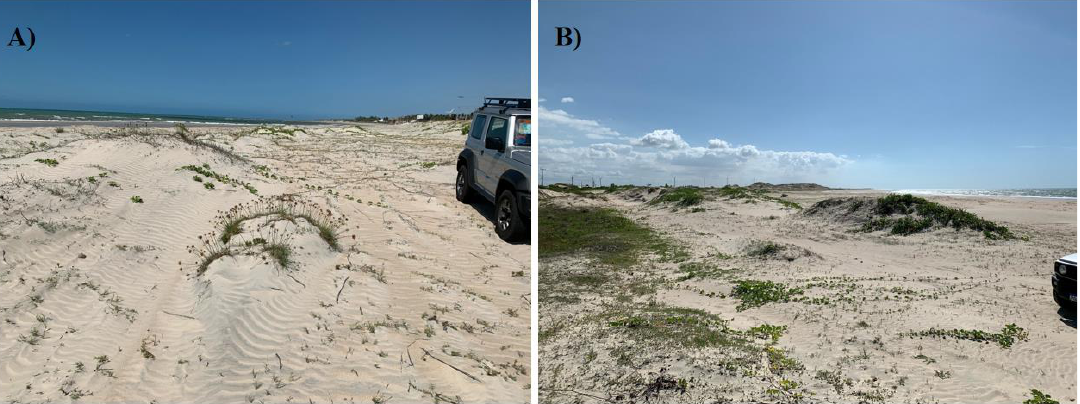
Figure 10. ( A ) Sand shadows on lower insipient foredune; ( B ) incipient foredune highlighted by elongated ridges parallel to the wind and oblique to the beach in